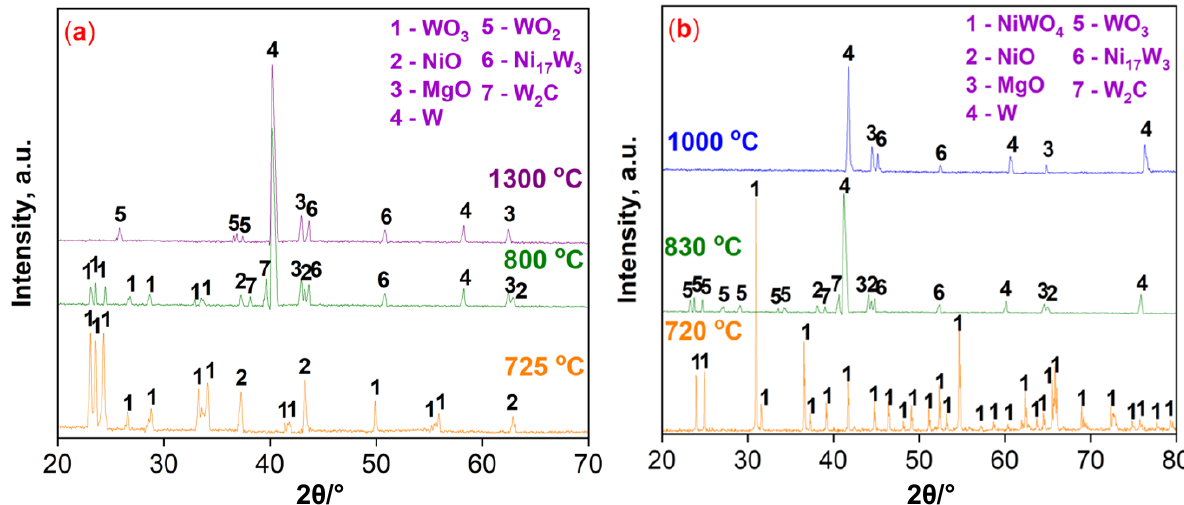
Figure 4. XRD patterns of the NiO + WO 3 + 2.5Mg + 1.5C (( a ) 725 °C, 800 °C and 1300 °C) and NiWO 4 + 2Mg + 2C (( b ) 720 °C, 830 °C and 1000 °C) mixtures, β = 300 °C min − 1 .